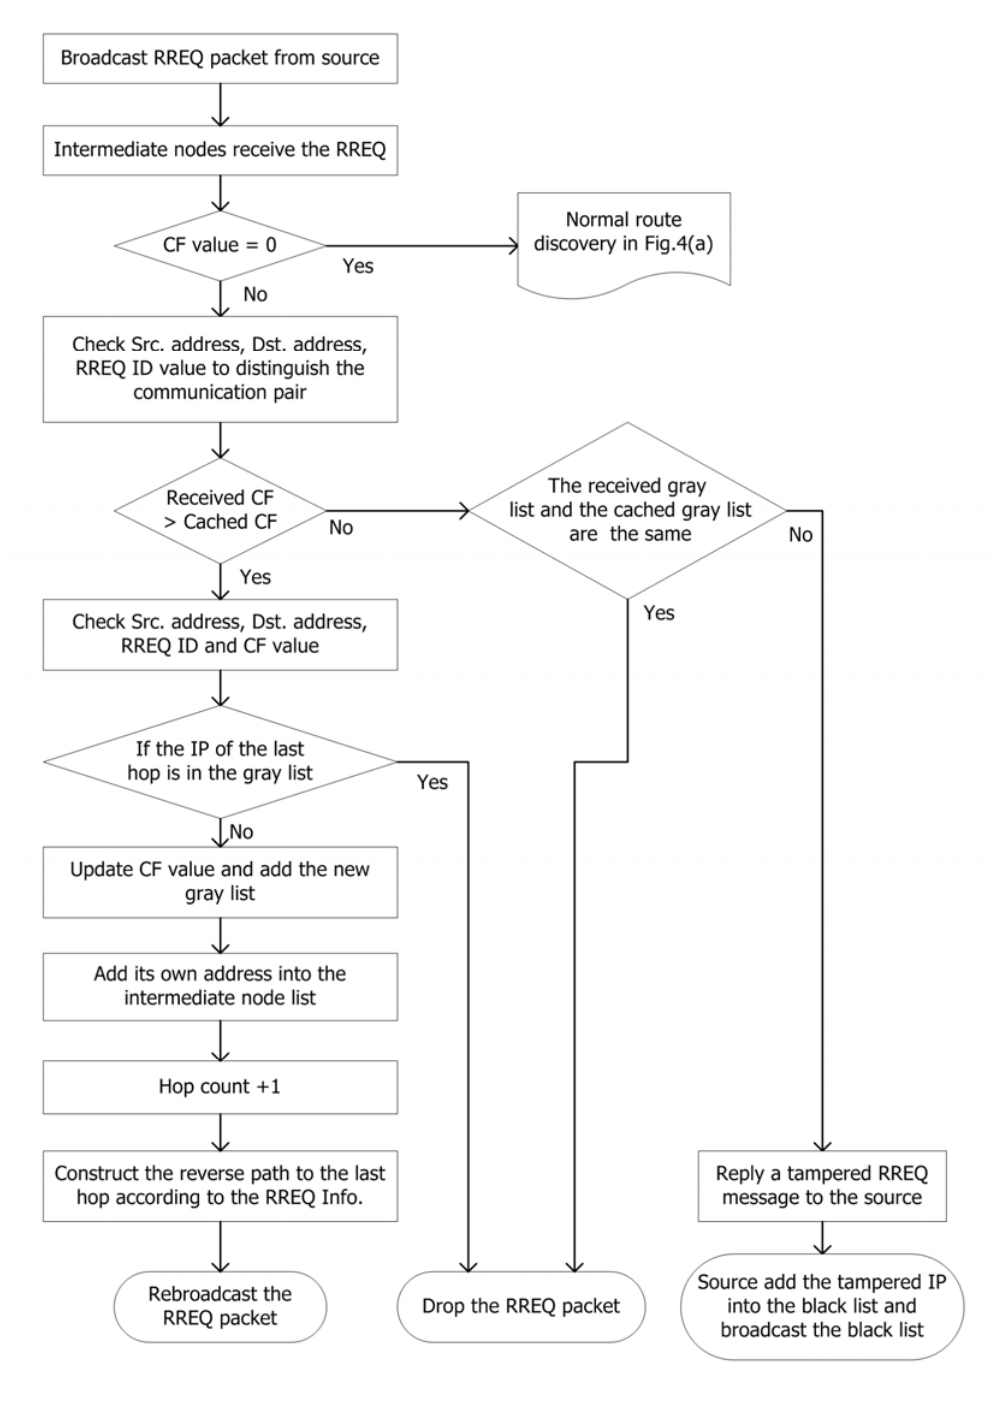
Figure 6. Graylist broadcast in MHA